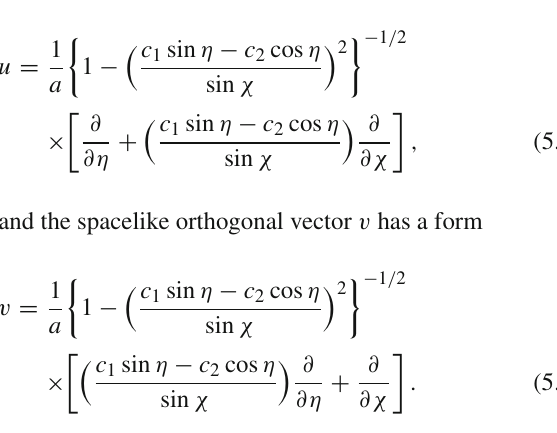
(5.13), the evolution vector u is given